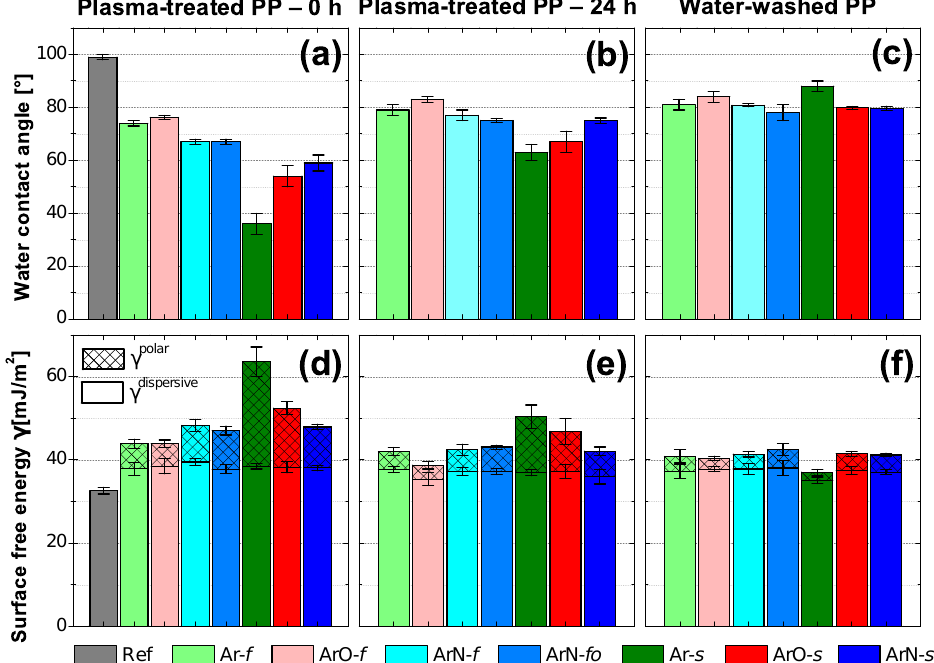
Figure 4. Water contact angle of a sessile droplet measured ( a ) right after treatment (0 h), ( b ) one day after treatment (24 h), and ( c ) after being submerged into demineralized water (water washed); surface free energy divided into the polar and dispersive part determined from contact angles measured ( d ) right after treatment (0 h), ( e ) one day after treatment (24 h), and ( f ) after being submerged into demineralized water